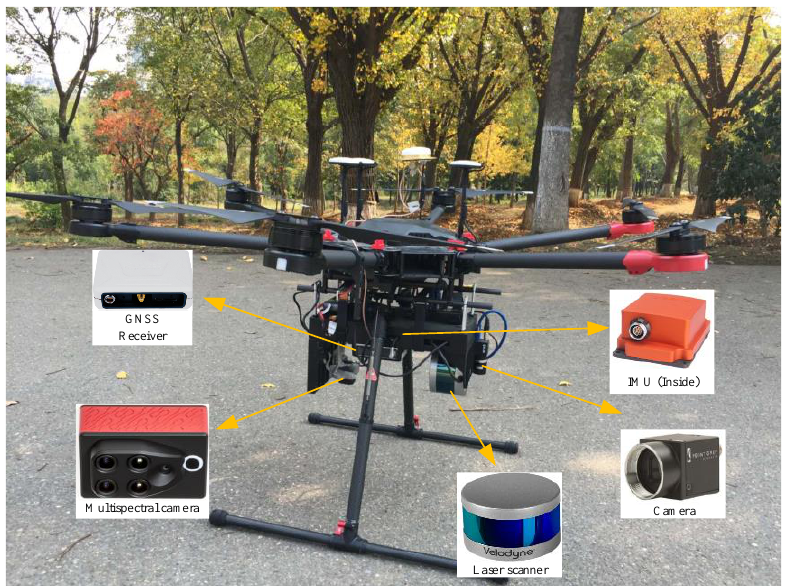
Fig.1 System description of Kylin Cloud. ( For a more detailed description, see (Dai et al., 2018; Li et al., 2019) ) Sensor